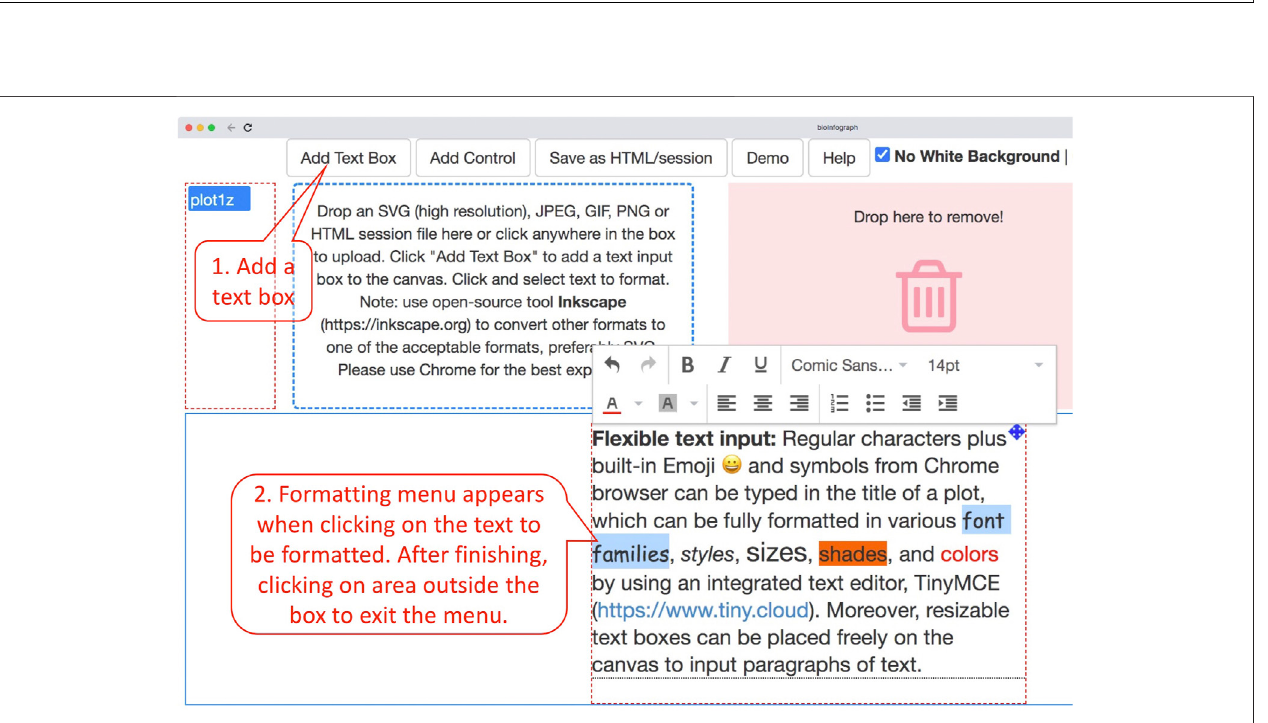
Frontiers in Genetics |